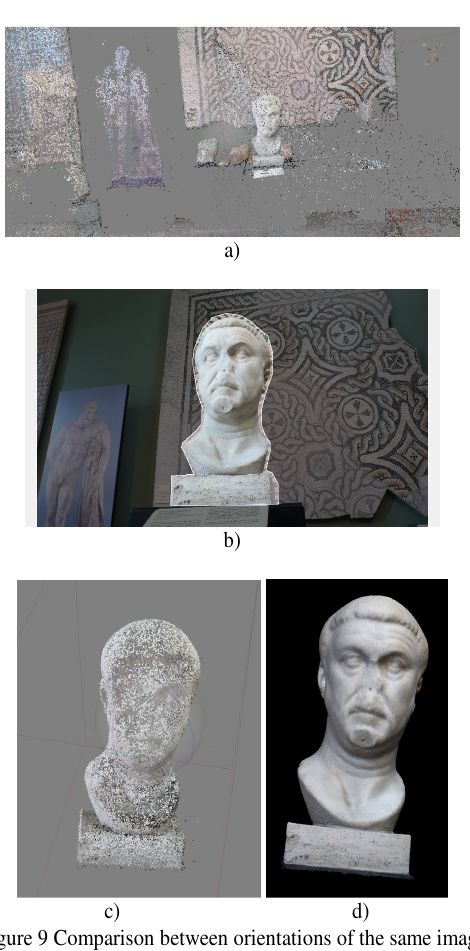
Figure 9 Comparison between orientations of the same images with or without masking: a) alignment points with no mask.